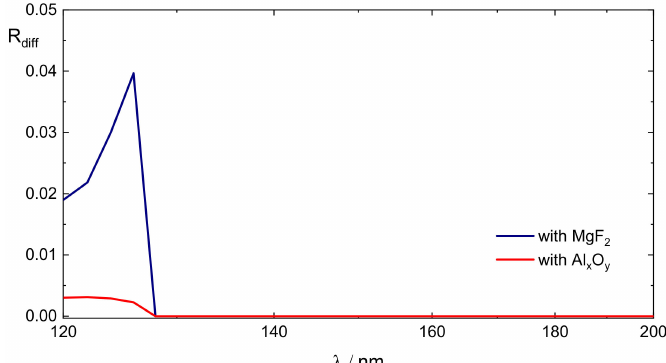
Figure 9. Calculated diffraction efficiencies for model surfaces with σ = 2 nm and Λ = 128 nm.